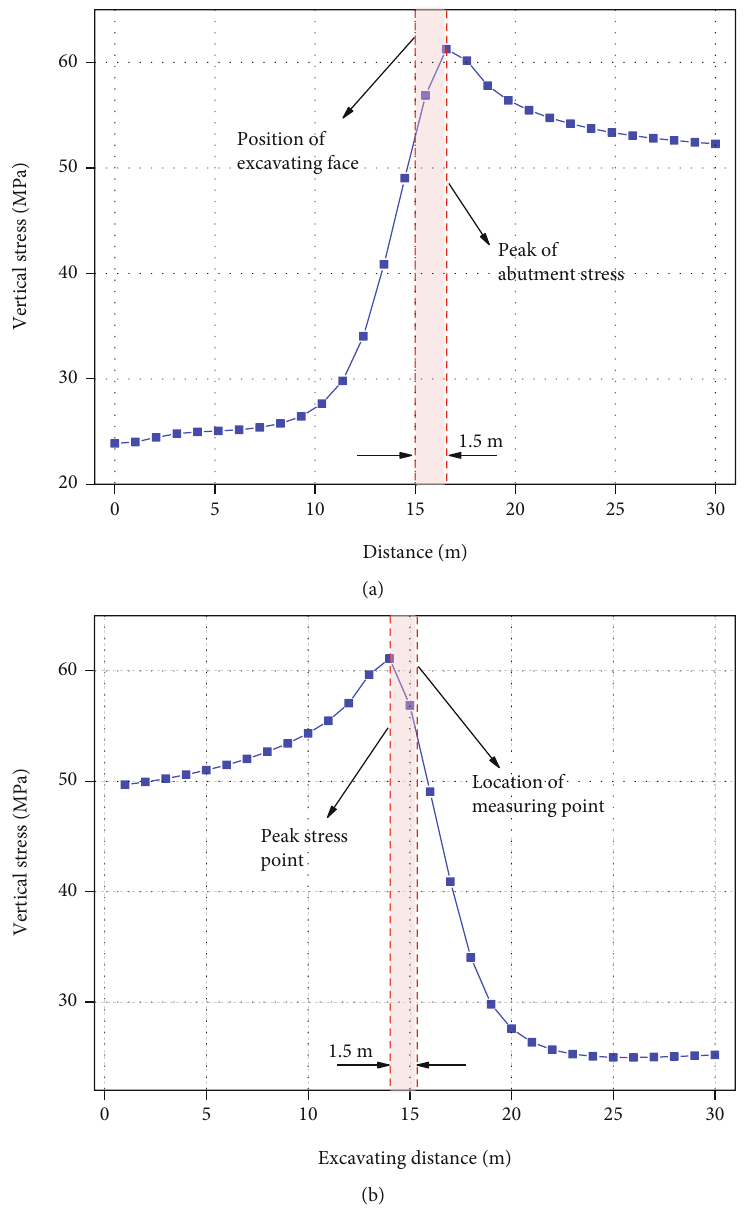
Figure 6: Characteristics of solid coal rib stress disturbance during cyclic excavation of gob-side roadway: (a) the vertical stress distribution law of the solid coal rib along the axial direction of the roadway when the roadway is excavated to 15 m and (b) the vertical stress evolution law of solid coal rib at 15.5m of roadway mileage during 30m of roadway